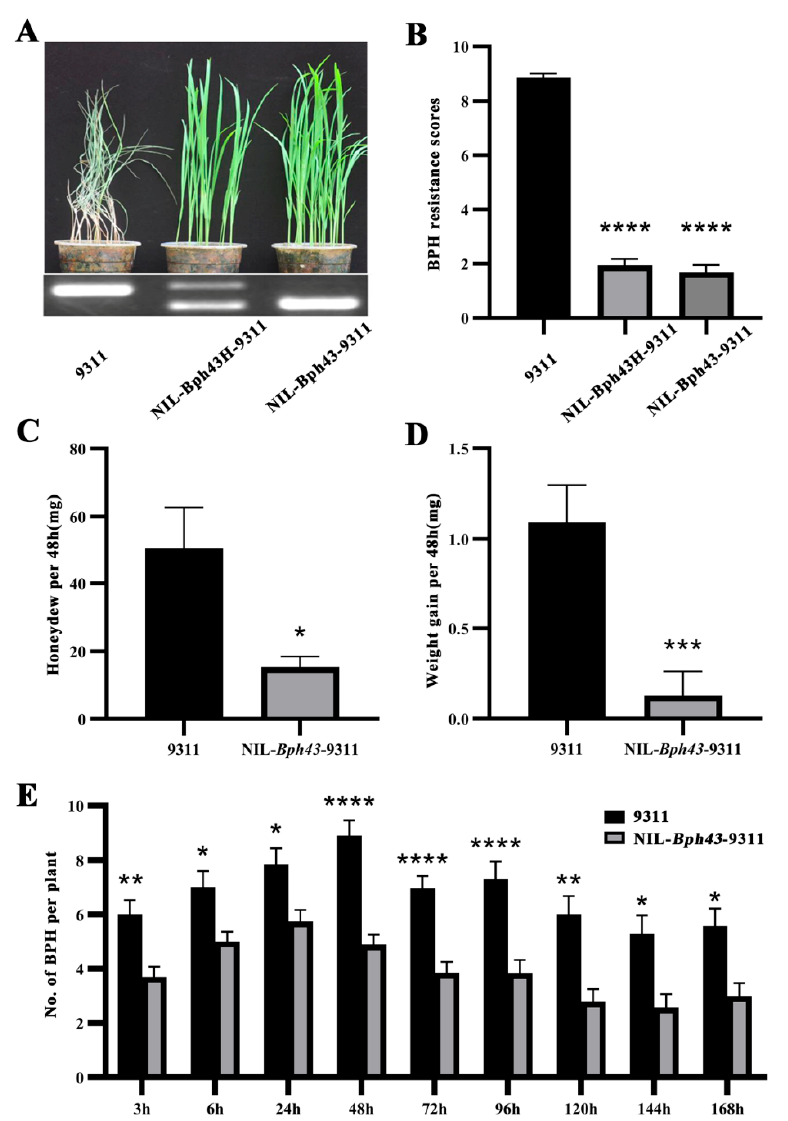
Figure 3. Characterization of BPH resistance of NIL- Bph43 -9311: ( A ) seedling resistance tests of heterozygous and homozygous NIL- Bph43 -9311 plants. The PCR band patterns amplified with insertion-deletion (InDel) markers 16–26 showed that NIL- Bph43 -9311 was homozygous for Bph43 and heterozygous for NIL- Bph43H -9311 and 9311 contained no Bph43 ; ( B ) BPH-resistance scores of 9311, NIL- Bph43H -9311, and NIL- Bph43 -9311; ( C ) honeydew excretion; and ( D ) weight gains of BPH feeding on NIL- Bph43 -9311 and 9311 for 2 days; ( E ) numbers of BPH insects settled on NIL- Bph43 -9311 and 9311 in the two-host choice test. Data represent means ± SEM of 20 replicates. The asterisks indicate significant differences (*, p < 0.05; **, p < 0.01; ***, p < 0.001; ****, p < 0.0001; Student’s t